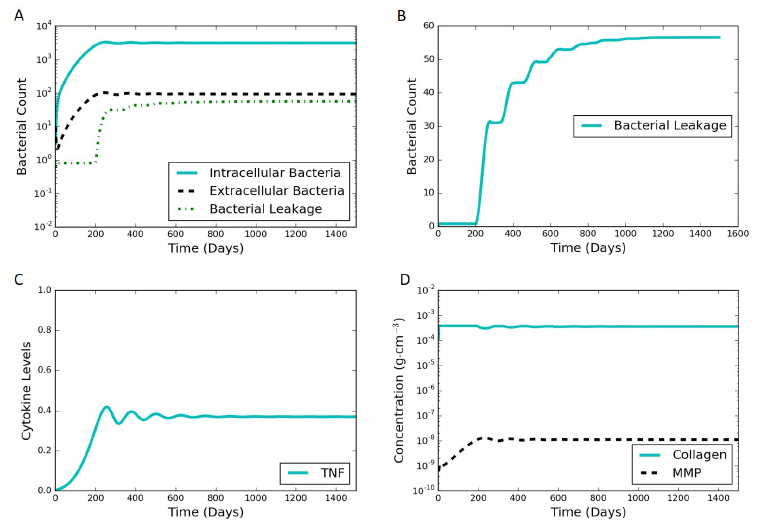
Figure 4. Typical simulation results leading to latent infection. All the concentrations and populations stabilize over time, indicating latency. ( A ) bacterial populations and cumulative bacterial leakage (log scale) vs. time. The intracellular, extracellular, and leaked bacterial concentrations are successfully controlled by the immune system around 200 days; ( B ) cumulative bacterial leakage (linear scale) vs. time; ( C ) dimensionless concentration of cytokine tumor necrosis factor (TNF)- α (linear scale) vs. time; ( D ) concentrations of MMP and collagen vs. time on a log scale.